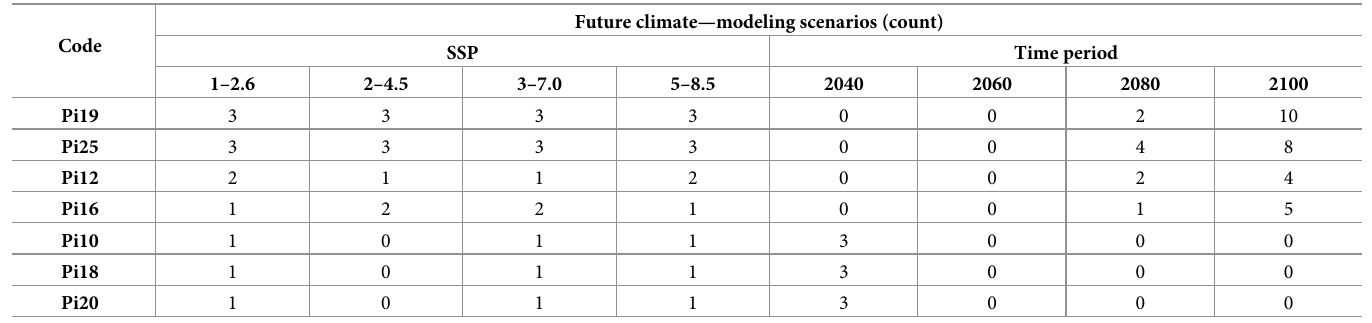
Table 7. Most frequent SSPs and time periods for Pucaras that headed the first three positions of maximum erosion.